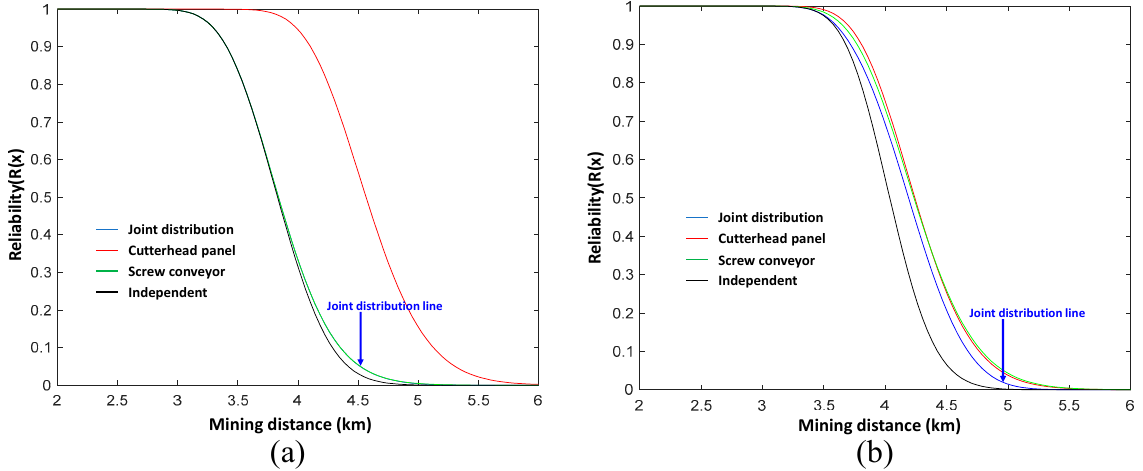
Figure 10. Joint distribution of the reliability function with ( a ) the modified cutter head and ( b ) the modified screw conveyor.